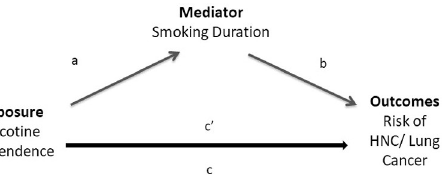
Fig 2. The decomposition of effects for the relationship between nicotine dependence and the risk of Head and Neck Cancer (HNC) and lung cancer, mediated through smoking duration. The total effect, denoted by c , is the logistic regression coefficient of nicotine dependence on the outcomes (risk of HNC and lung cancer) without controlling for the mediator. The direct effect, denoted by c’ , is the effect coefficient of nicotine dependence in a logistic regression with nicotine dependence, and the mediator on the outcomes. a denotes the effect coefficient of nicotine dependence on smoking duration. b denotes the effect coefficient of smoking duration on the outcomes, in the model with both the exposure and mediator. The indirect effect, is the component of the total effect that is mediated through smoking duration ( c-c’ ) in the relationship between nicotine dependence and the outcomes; it is denoted by a � b